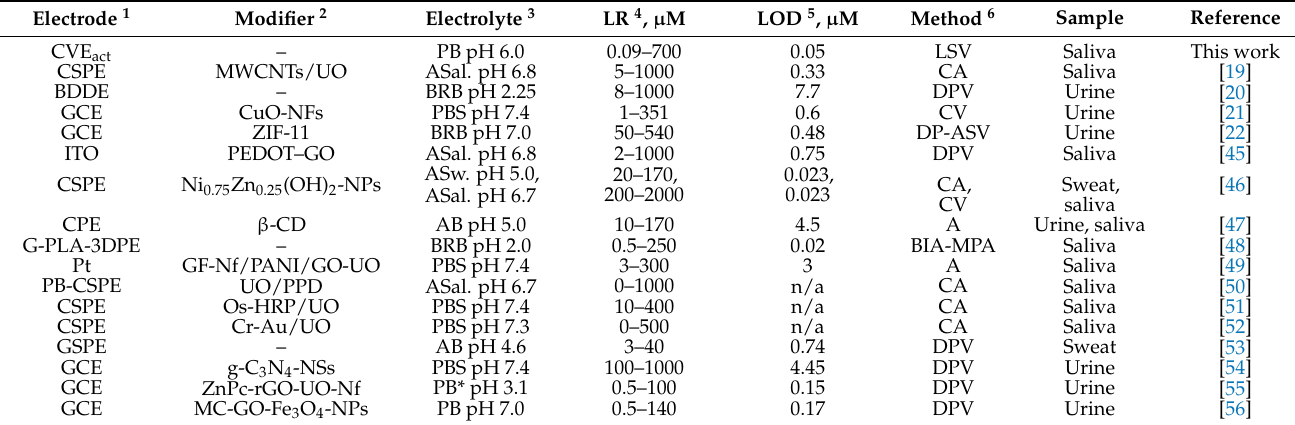
Table 3. Comparison of the most recent electrochemical (bio)sensors for the determination of UA in non-invasive biologi- cal samples.